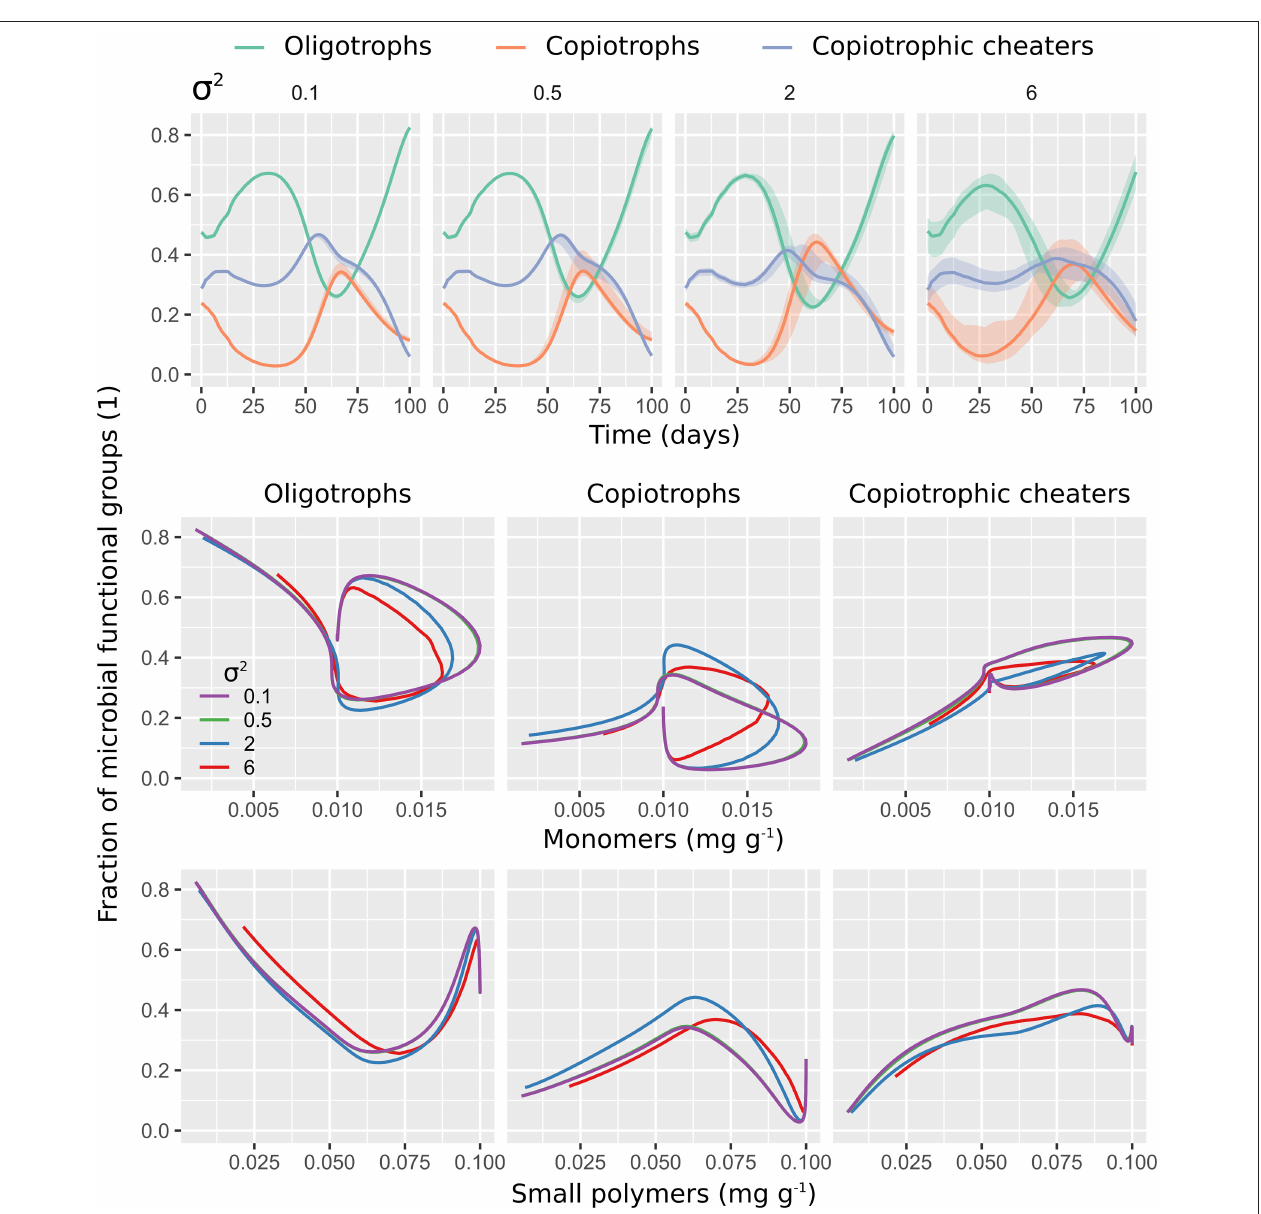
FIGURE 6 | Spatial clustering of microbial decomposers limits activity and access to monomers by copiotrophic cheaters. Moderate clustering facilitates the access to monomers of copiotrophs and their contribution to total biomass. The first row shows the contribution of microbial functional groups (active and dormant biomass) to total microbial biomass with respect to time. The second and the third row show a phase-space plot of microbial functional group fractions against dissolved monomers (second row) and dissolved small polymers (third row). Each model output is shown in response to the spatial heterogeneity of the initial distribution of microorganisms ( σ 2 = 0.1, 0.5, 2, 6). Lines indicate medians of 100 realizations (aggregated over the 100 × 100 mm 2 soil domain). Shaded areas (first row) show minimum and maximum